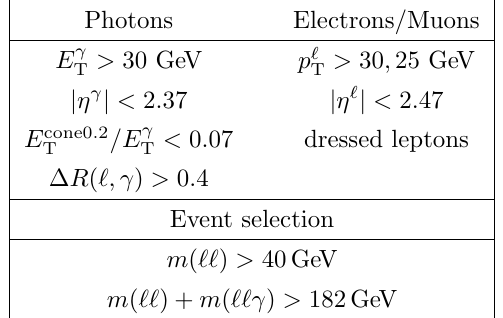
Table 4 . De(cid:12)nition of the ‘ + ‘ (cid:0) (cid:13) particle-level (cid:12)ducial phase-space region. For the lepton p T requirements, the (cid:12)rst (second) number speci(cid:12)es the minimum allowed p T of the lepton with the highest (second-highest) value of transverse